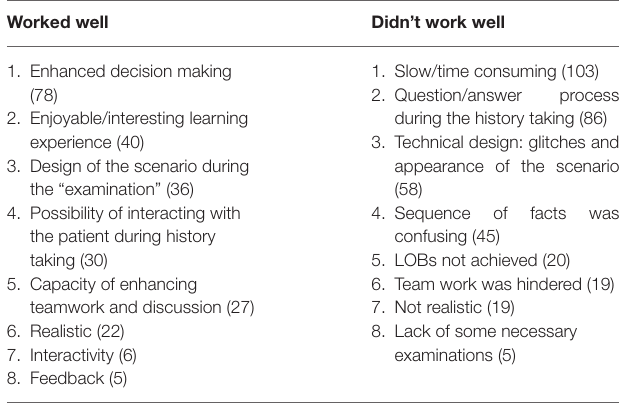
TABLE 3 | Categorization of responses to two open-ended questions (“what worked well during SL PBL,” from 155 students) and (“what didn’t work well during SL PBL”; from 199